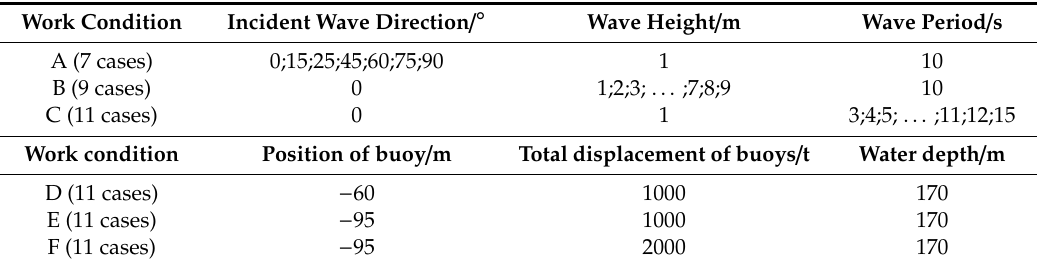
Table 3. Working condition settings.